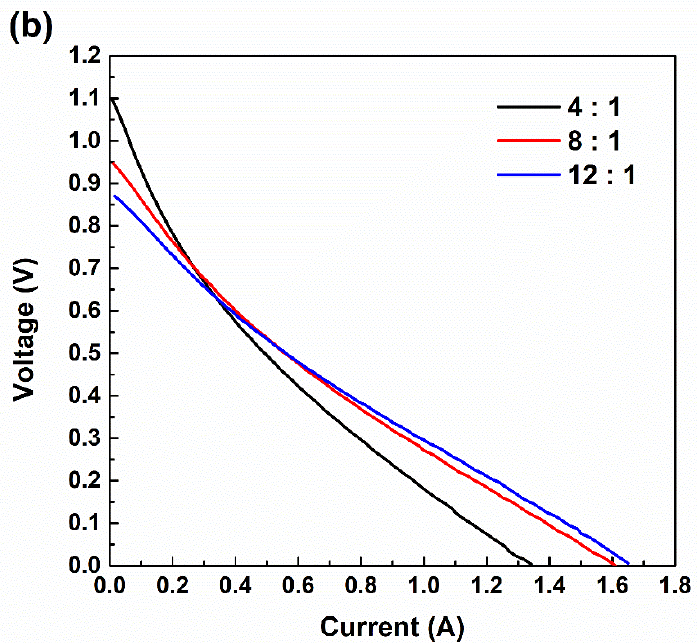
Figure 5. Current–voltage (I–V) curves of RED stacks with sizes ( a ) 5 × 5 cm 2 and ( b ) 15 × 15 cm 2 , according to PIEM compositions.